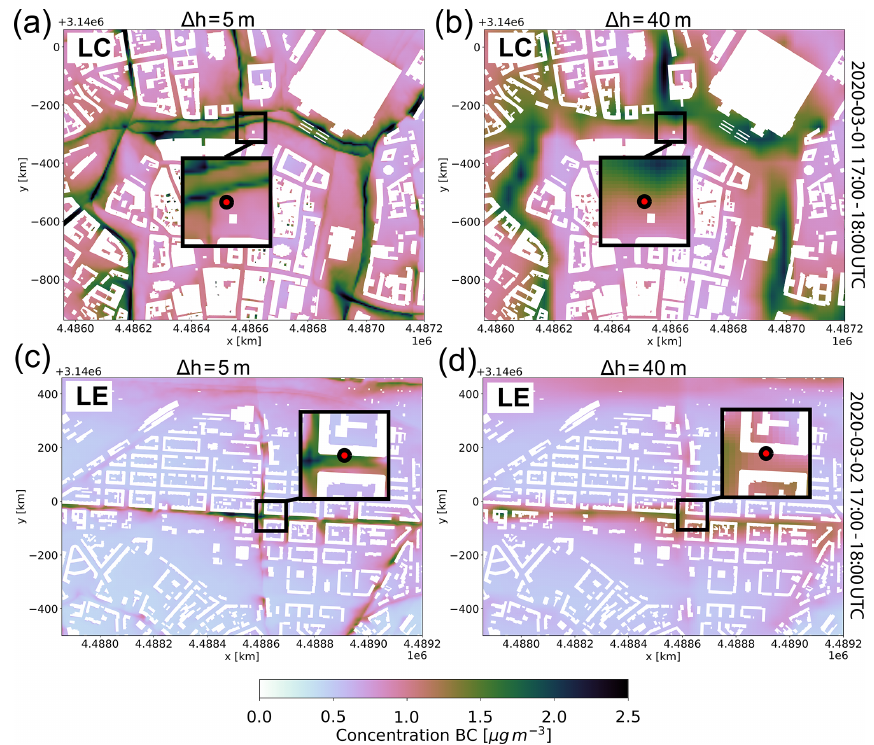
Figure 17. Qualitative comparison of the spatial distribution of modeled BC between the finest tested horizontal grid spacing of 5m (a) and the default 40m (b) with domain LC. Model results are temporally averaged for the rush-hour period on the evening of 1 March, and spatially interpolated at the height of corresponding air-monitoring site. In the locally magnified view of the insets, the air monitoring site is marked by a black circle. In (c) and (d) a similar comparison is shown with domain LE featuring the second rush-hour peak in the evening of 2